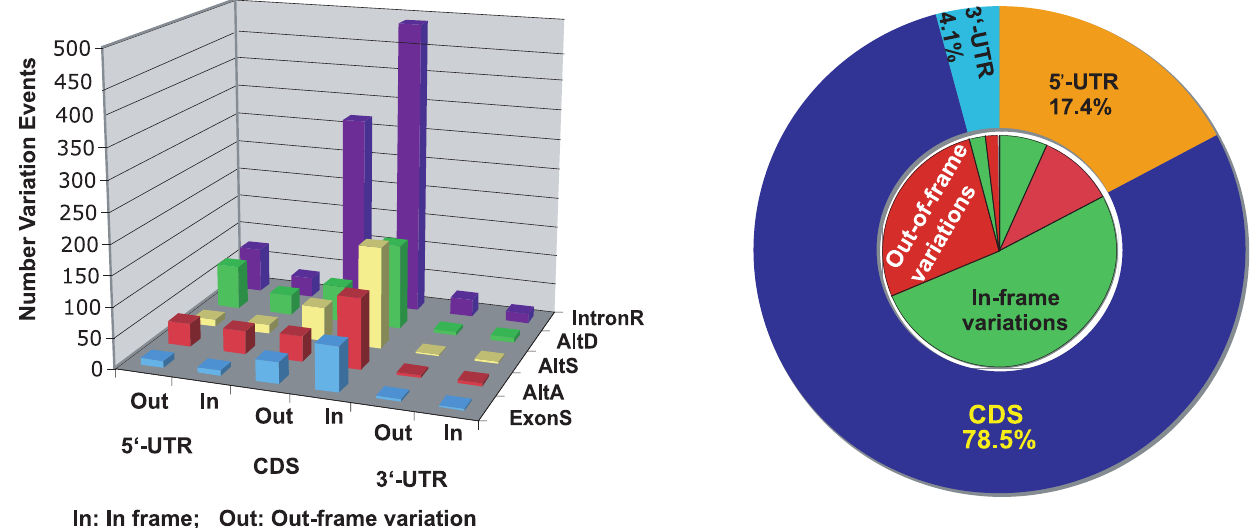
Figure 3. Transcript structure variation (TSV) locations and length difference in Anophelesgambiae . Left panel shows the detail of variation locations and length differences in different TSV types. For all TSV types, the open reading frames of variations within CDS regions are conserved. Right panel shows the summary of variation locations and length differences. The green and red colors in the inner circle represent in- frame and out-of-frame variations respectively. More than 65% of variations at CDS regions are in-frame, while variations at un-translated regions (UTR) tend to be out-of-frame. Therefore, most transcript structure variations just insert or delete some amino acids without changing the protein structures. The data also show that more variations are at 5 9 -UTR than at 3 9 -UTR, which suggests the higher efficiency on gene regulation at 5 9 -UTR than 3 9 -UTR.